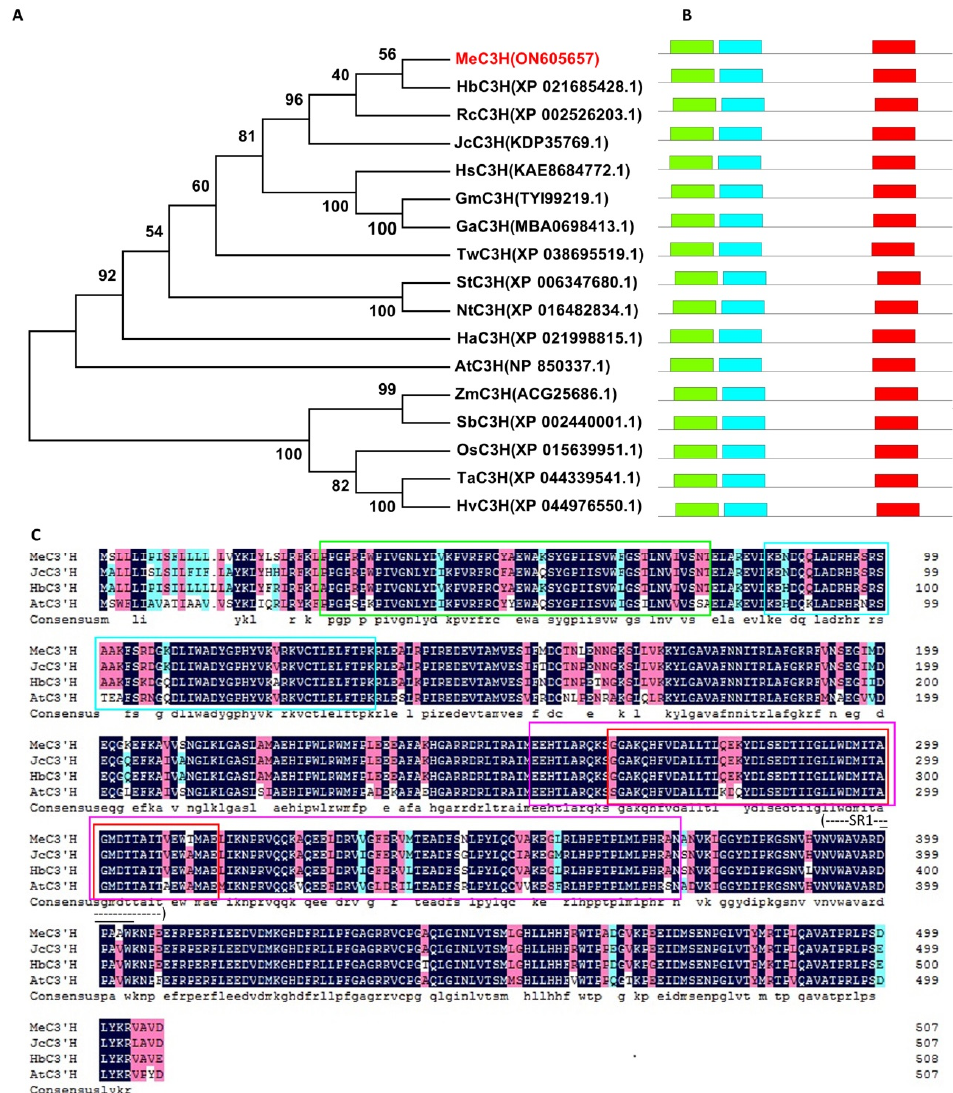
Figure 1. Phylogenetic tree, conserved motifs, and amino acid alignments of C3 ′ Hs from various species. ( A ) A phylogenetic tree of C3 (cid:48) Hs was constructed using the Neighbor-Joining method in MEGA7.0. Bootstrap values from 1000 replicates are shown at each node. C3 (cid:48) Hs in the tree are from the following species: AtC3 (cid:48) H ( Arabidopsis thaliana ); GaC3 (cid:48) H ( Gossypium aridum ); GmC3 (cid:48) H ( Gossypium